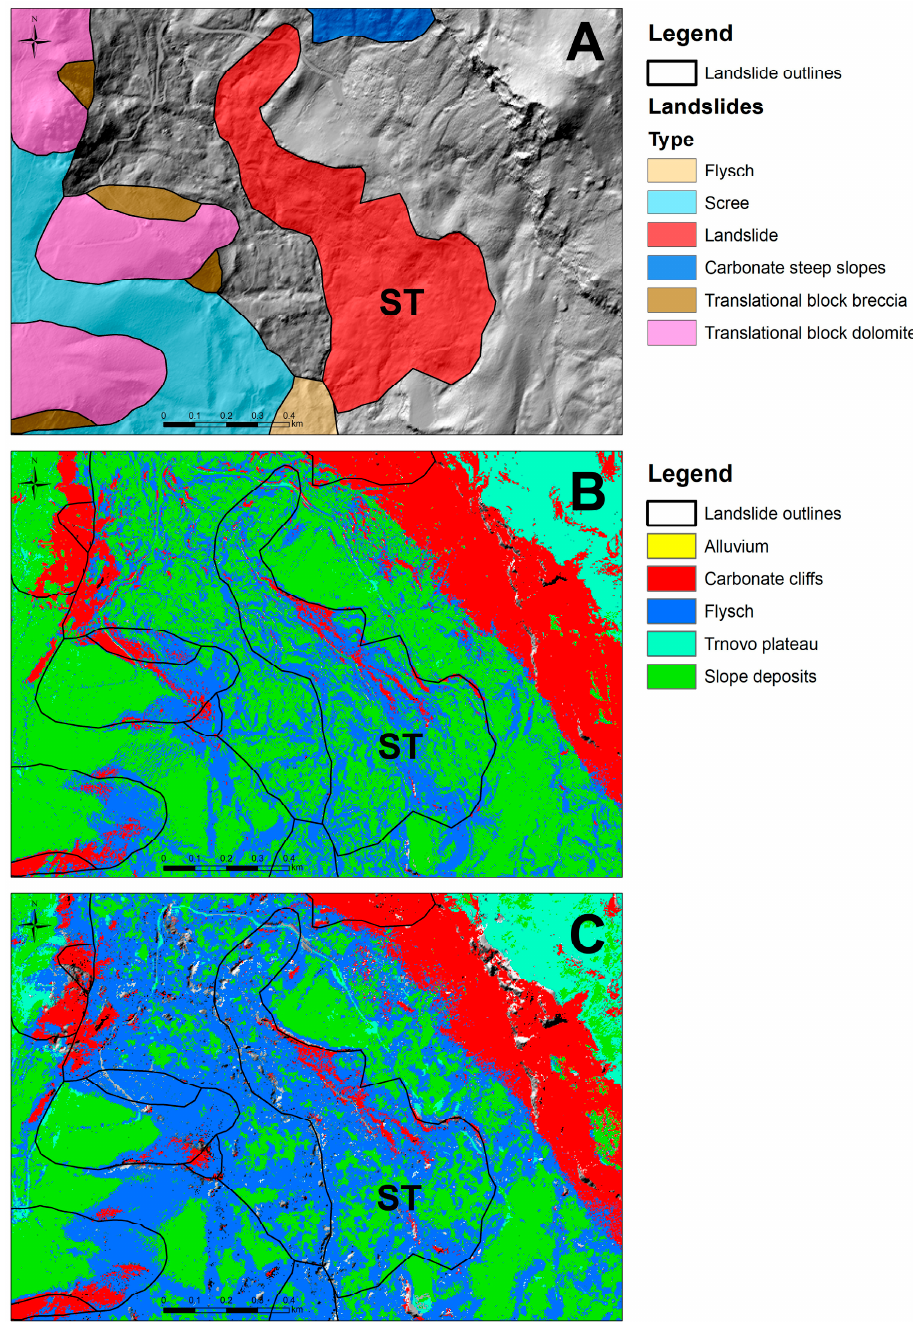
Figure 6. Stogovce landslide area. ( A ) outlines and main sediments of the litho-geomorphological units; ( B ) original MLC results; and ( C ) results from this study.